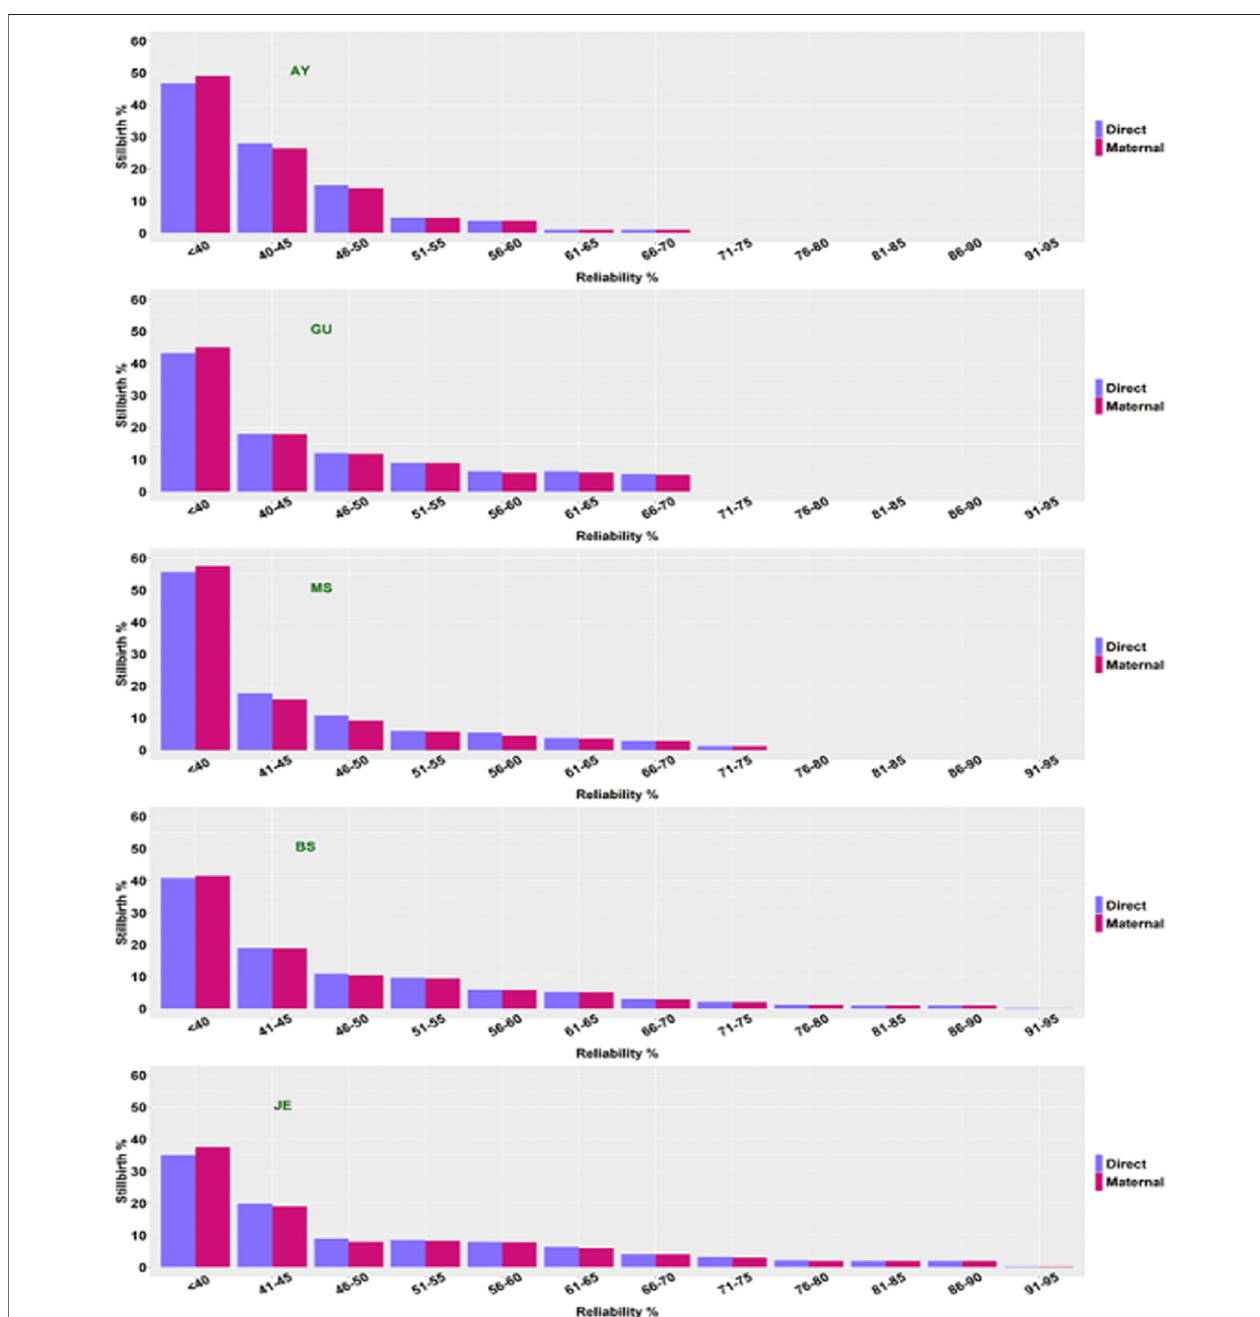
FIGURE3| Thedistributionsofreliabilities(%)fordirectandmaternalPTAforthepercentageofstillbirths(%SB)in fi venon-Holsteindairybreeds.AY=Ayrshire;GU = Guernsey; MS = Milking Shorthorn; BS = Brown Swiss; JE = Jersey.